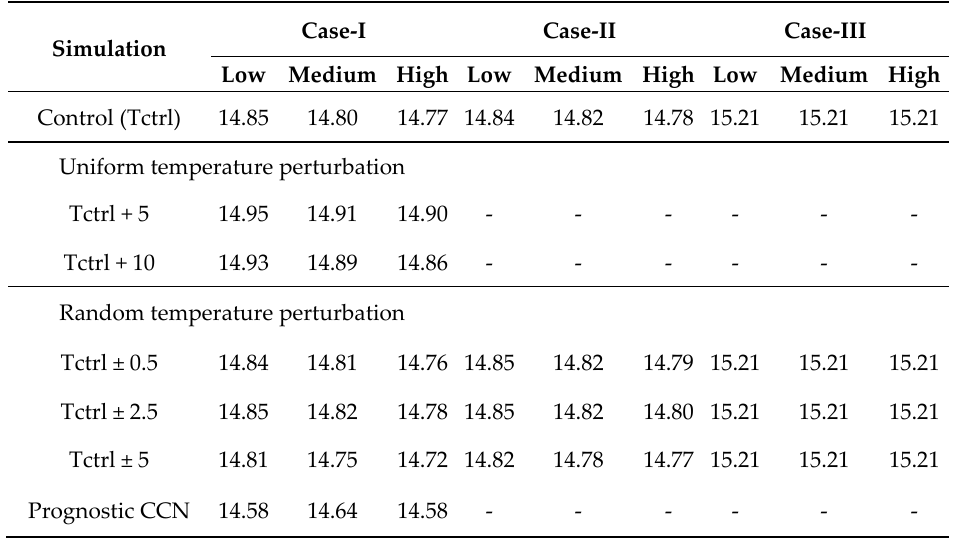
Table 1. Inter-comparison of domain and time averaged cloud droplet effective radius ( μ m). Dashes indicate no simulations were performed for the